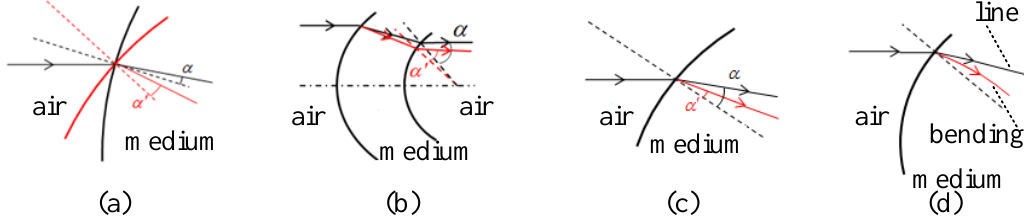
Figure 3. Temperature and ray propagation. ( a ) Thermally induced surface slope affects the emergent angle; ( b ) changing the emergent angle of the front surface affects that of the rear surface; ( c ) changing the refractive index at the incident point affects the emergent angle; ( d ) the radial gradient refractive index affects the propagation bending path.